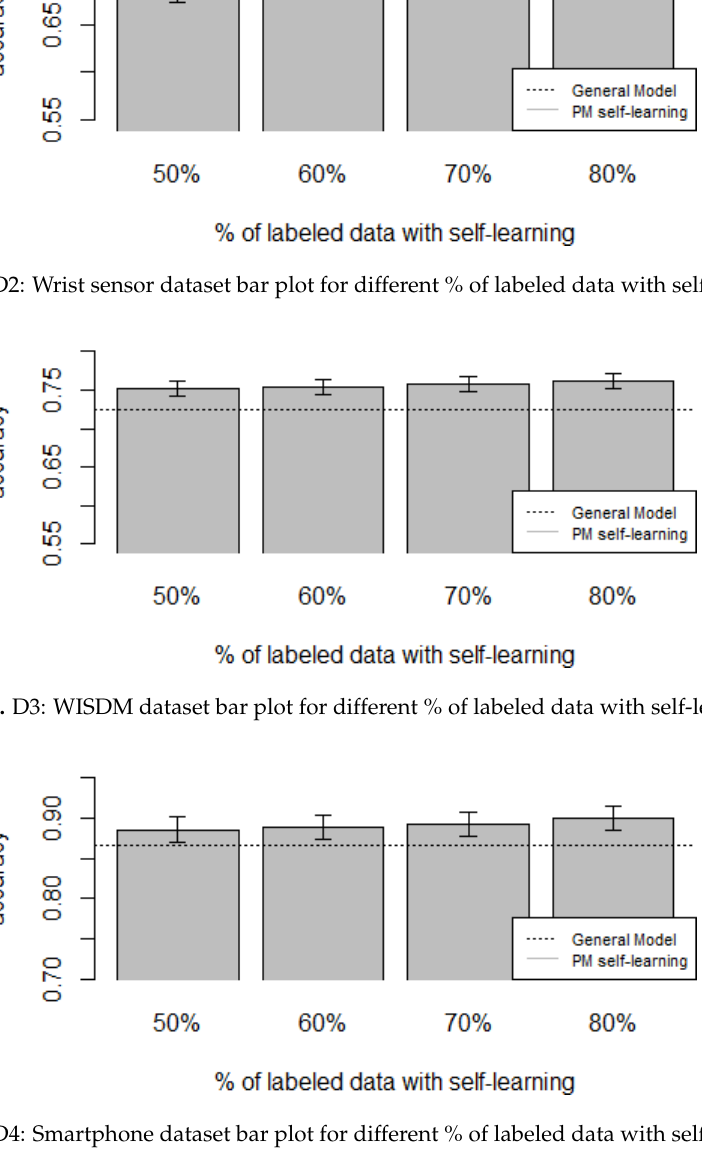
Figure 13. D4: Smartphone dataset bar plot for different % of labeled data with